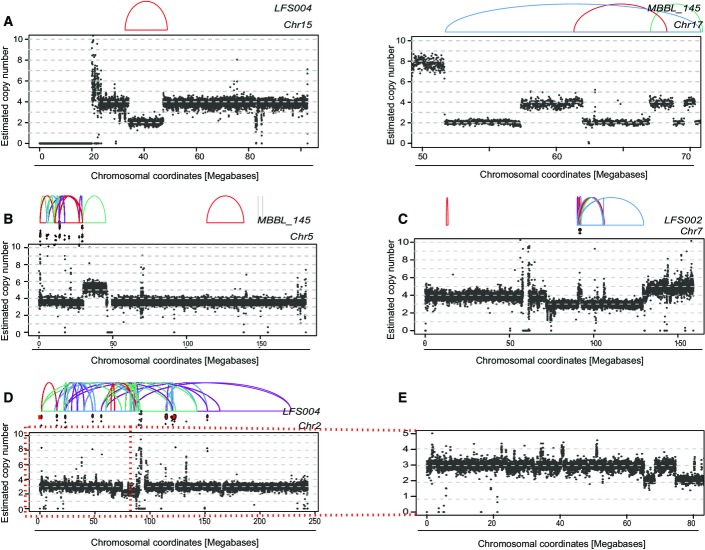
Evidence for tetraploidy being an initiating event in SHH-MBsThe plots display read depth from raw read counts with estimated copy numbers together with SR graphs. SRs are color-coded as indicated in FigEV3 earlier.
Two exemplary SR patterns, underlying presumably sequential SRs, exhibiting copy number state switches of 2 (indicating that these sequential SRs arose before tetraploidy).

Estimated copy number of MB145, chromosome 5 together with SRs. Double minute chromosomes resulting from chromothripsis are indicated off-scale.

Estimated copy number of LFS02, chromosome 7 together with SRs. (Double minute chromosomes resulting from chromothripsis indicated off-scale).

Estimated copy number of LFS04, chromosome 2 together with SRs. (Double minute chromosomes resulting from chromothripsis indicated off-scale). The region with numerous copy number switches of magnitude of 1 is highlighted and further examined in (E).

Zoom-in of chromosome 2, 0–80-Mb region. (Note the copy number switches of magnitude of 1).
Data information: These three cases (B–D) all show examples of tumors bearing the hallmarks of chromothripsis with double minute formation (Stephens et al, 2011; Rausch et al, 2012a). Except the massively amplified double minute chromosomes (which typically undergo repeated duplication after chromothripsis has occurred (Rausch et al, 2012a; Stephens et al, 2011)), all SRs were associated with copy number segment switches of 1, based on which we predict that tetraploidy (hyperploidy) preceded chromothripsis.